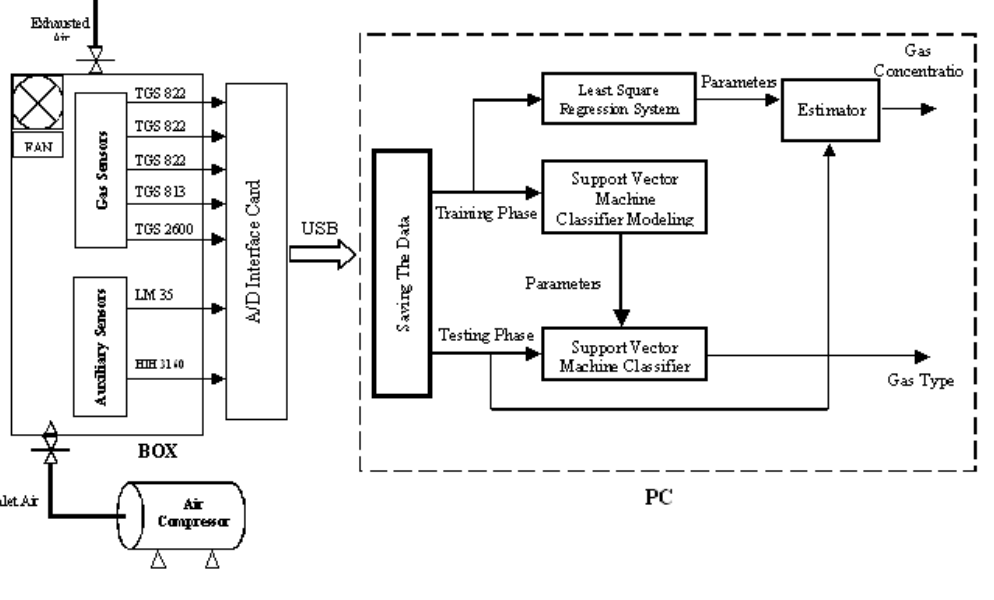
Figure 1. Block diagram of the